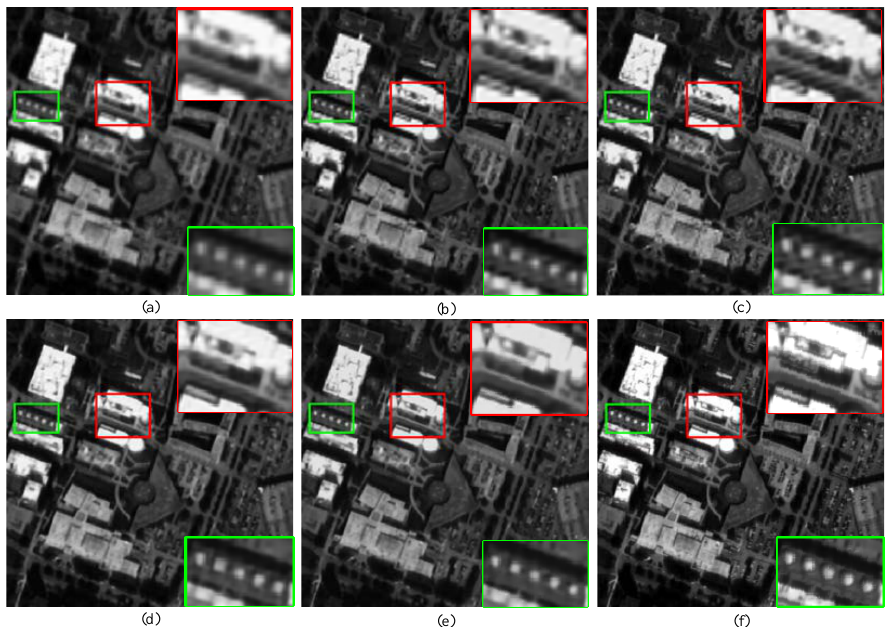
Figure 10. The SR results (band 5) of different methods by an upscaling factor of four, the testing data is cropped from Houston University (grss_dfc_2018) with size 512 × 512. ( a ) Result of Bicubic, ( b ) result of SSG [27], ( c ) result of SRCNN [40], ( d ) result of 3D-CNN [32], ( e ) result of the proposed MW-3D-CNN, and ( f ) original HR image.